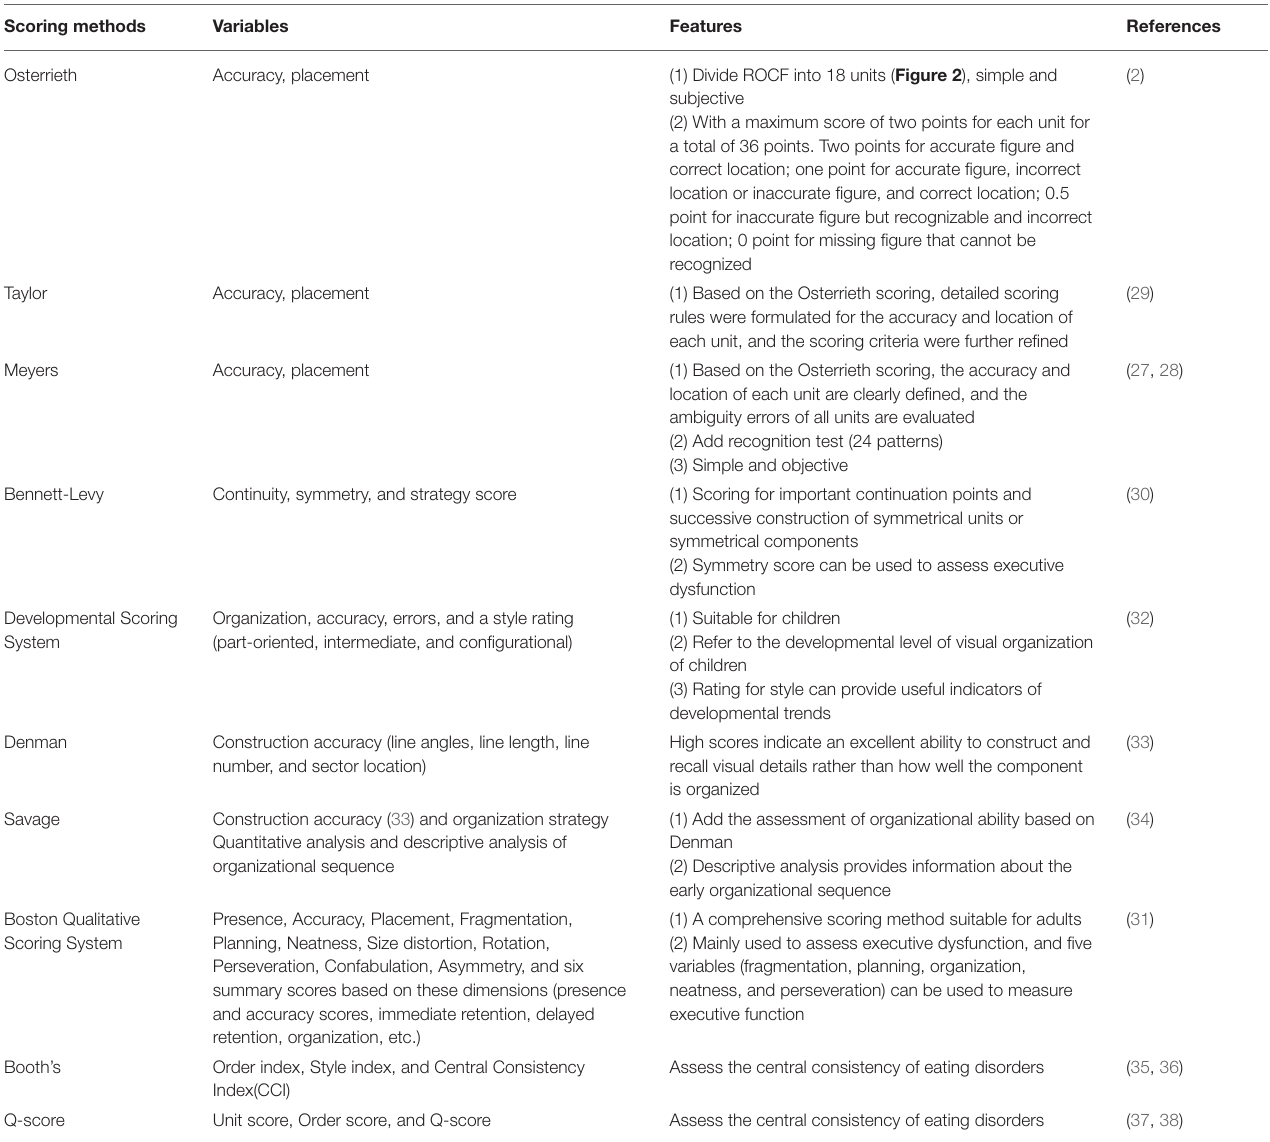
TABLE 1 | Traditional scoring methods of the complex figure